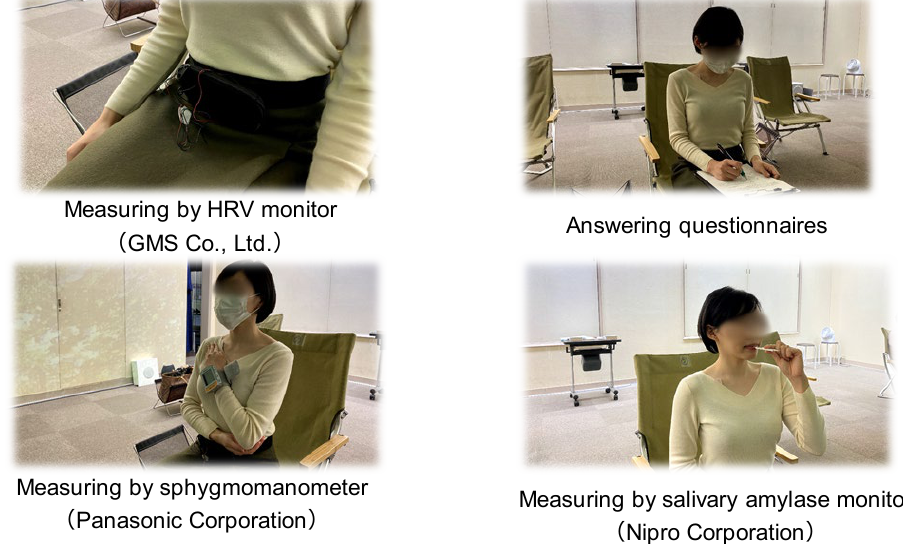
Figure 3. Measurement of each physiological indicator. Note: For the measurement of HRV, the sensor was attached to the body before the experiment, and the data logger was continuously fixed at the waist position for recording during the experiment. To measure blood pressure and pulse rate, a small arm-wrapped sphygmomanometer was used and fixed at the level of the heart each time during the measurements. Salivary amylase was also collected using a special regent. For the questionnaire survey, the experimental room was lit so that the participants could see their hands when answering the questions.